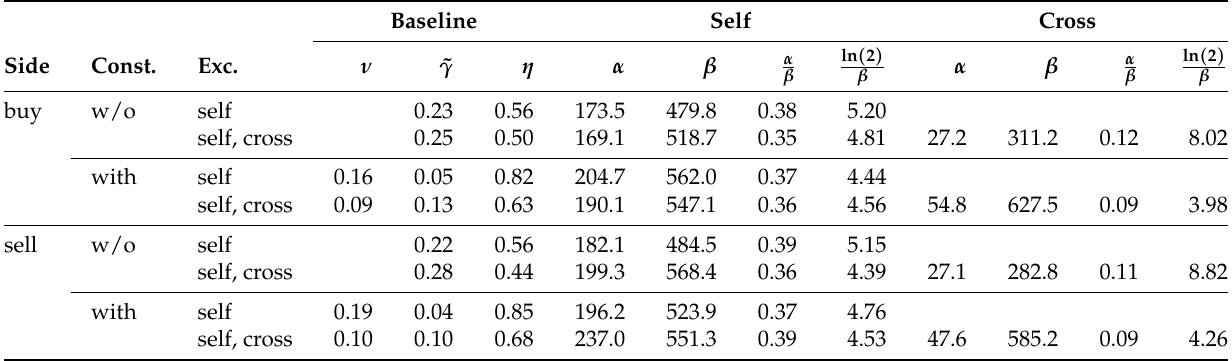
Table 4. Medians of the parameters of the baseline intensity function and the function controlling self- and cross-excitation of buy and sell market order arrivals as well as medians of the branching ratios and half-lifes resulting from these parameters. Baseline Self Cross Side Const. Exc. buy w/o self with self sell w/o self